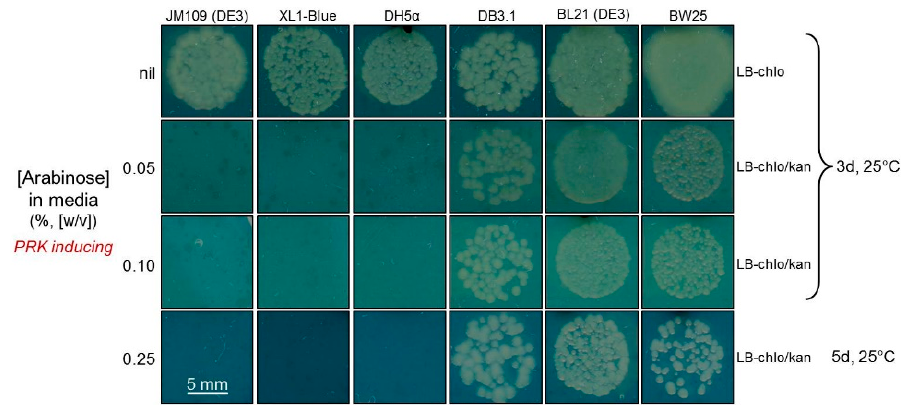
Figure 4. Comparative growth of di ff ering E. coli strains under increasing PRK-NPTII expression. Six E. coli strains were transformed with pACYC prk:kan and grown on LB-medium containing four di ff erent arabinose concentrations. Chloramphenicol (chlo, 30 µ g / mL − 1 ) and kanamycin (kan, 125 µ g / mL − 1 ) were included in the LB plates, as indicated.